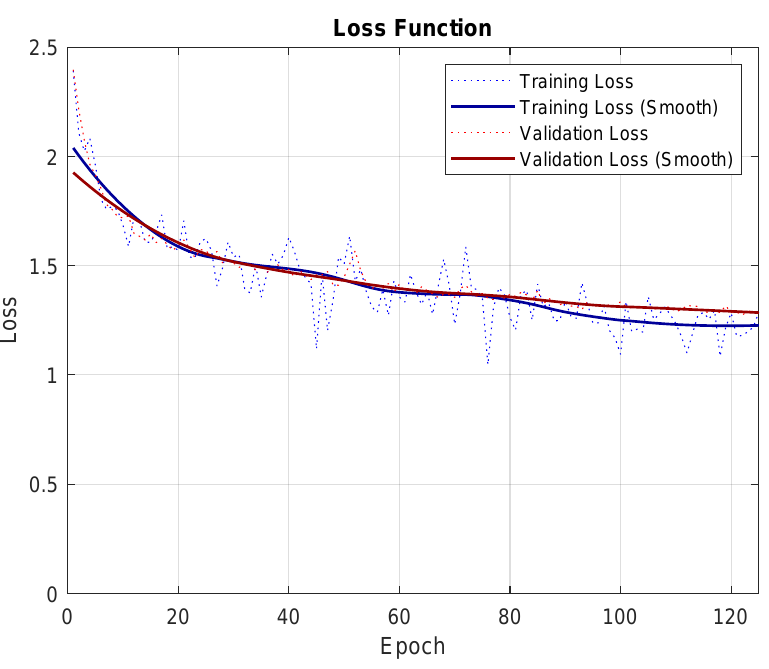
Figure 13. Loss function for the “Base” experiment with UNet for UOS2.